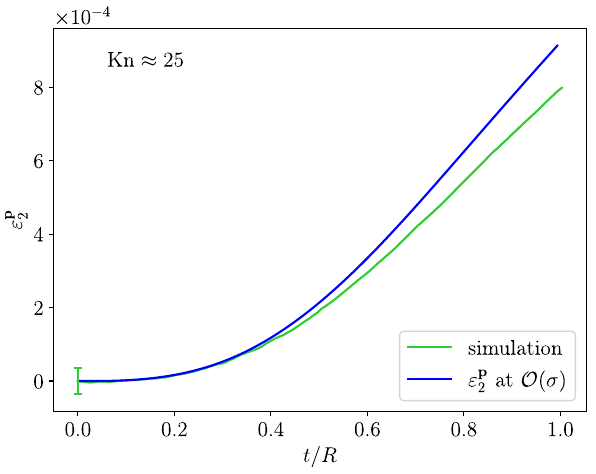
= v E at Kn ≈ 25. The results of 2 2